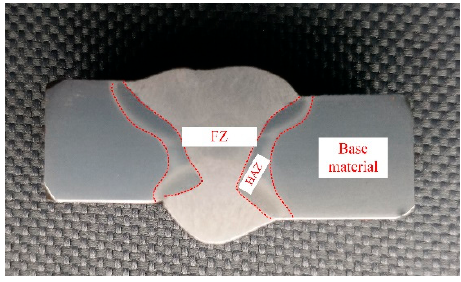
Figure 3. Cross-section profile of the ULCW (underwater local cavity welding) joint of Q690E steel.